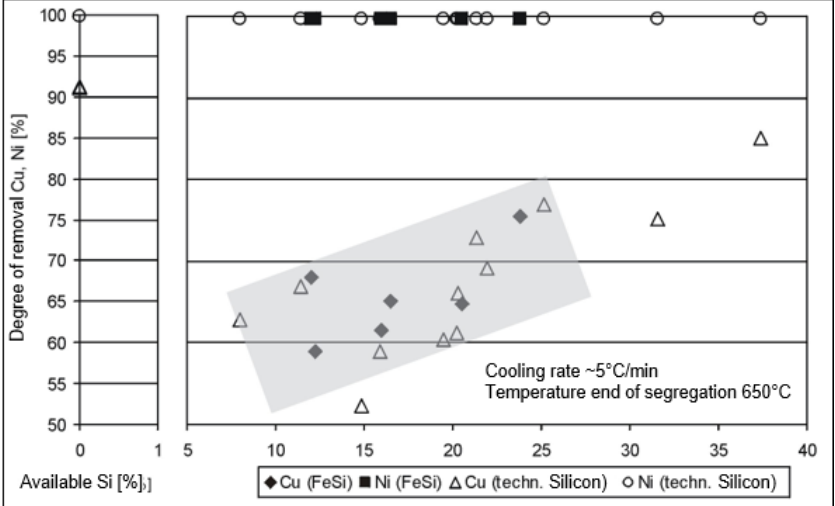
Figure 8. Quantity distribution of the products of the experiments with FeSi addition as a function of the “available” silicon (cooling rate ∼ 5 ◦ C/min, temperature segregation 650 ◦ C).